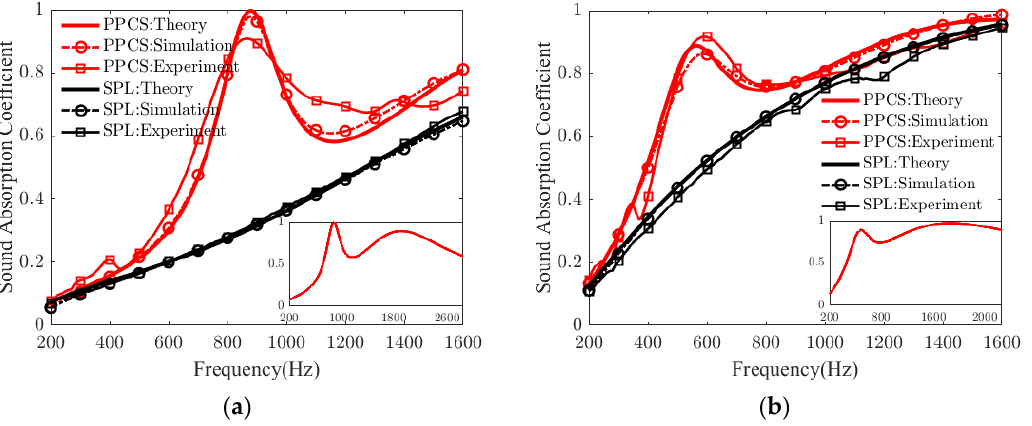
Figure 4. Sound absorption coefficients of PPCS under theory, simulation, and experiment. ( a ) Porous materials of melamine; ( b ) porous materials of polyurethane.